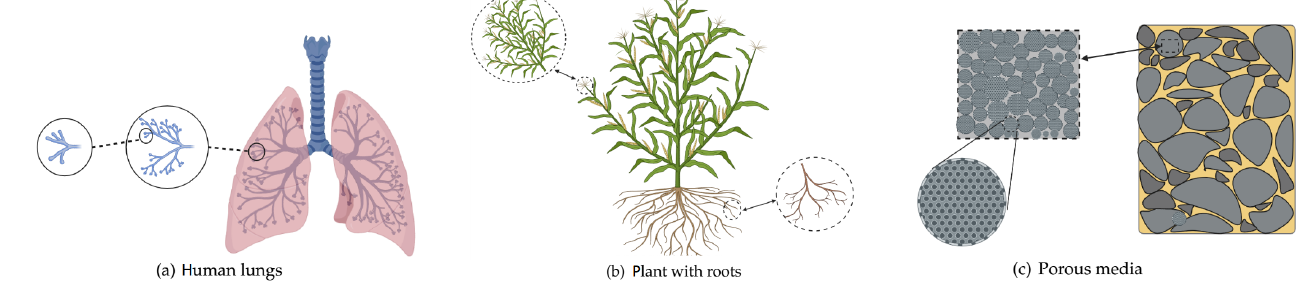
Figure 1. Examples of objects that display a self-similar “fractal” structure.